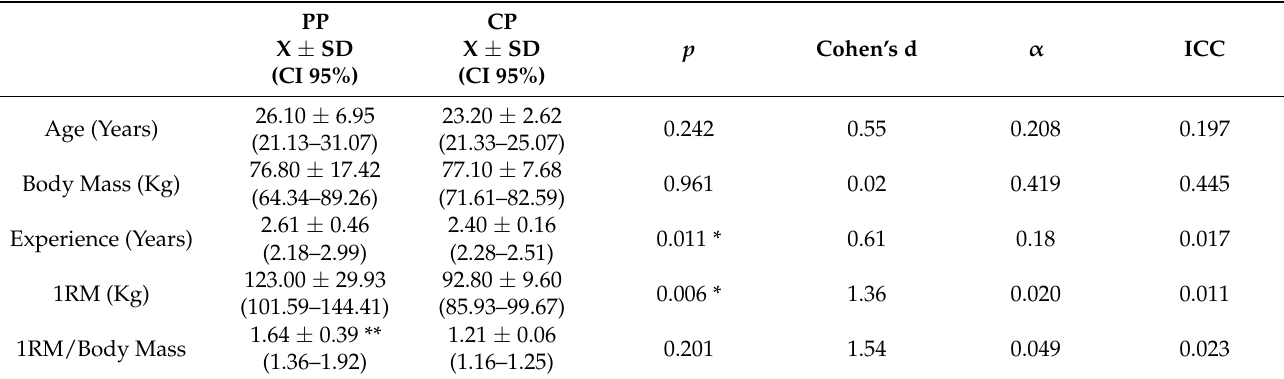
Table 1. Characterization of the sample.